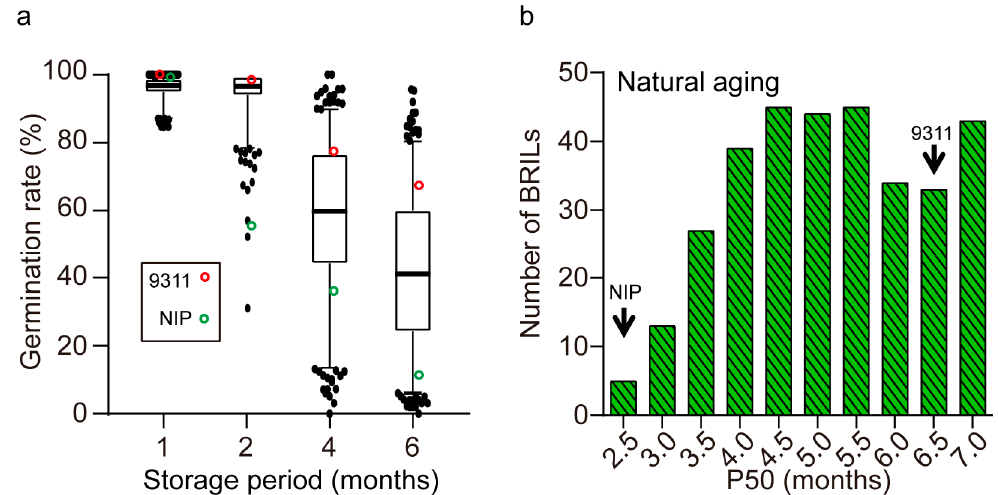
Figure 1. Seed germination of the parental lines and backcross recombinant inbred line (BRIL) population under natural storage. ( a ) Boxplot of germination rates after 1-, 2-, 4-, 6-month storage. The box edges indicate the range of the 25th to 75th percentiles with the mean value shown as the bold middle line. The whiskers represent the range of 5% to 95% of the data and outer dots are outliers. ( b ) Frequency distribution of seed storability as measured by P50, which is the time required for a reduction of viability to 50% under natural storage. Arrows indicate the means of parental lines Nipponbare (NIP) and 9311.